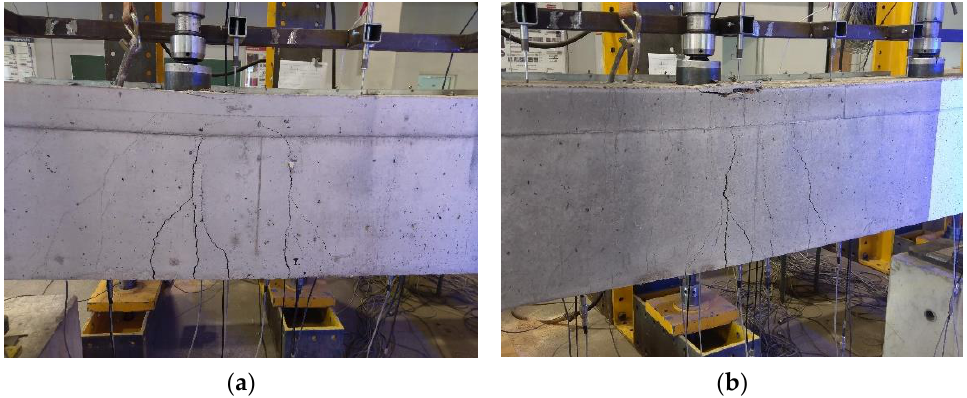
10 of 19 Figure 8. Crack propagation in BN3 and BL3 beams. Note: numerals given in figures indicate the applied load F (in kN).